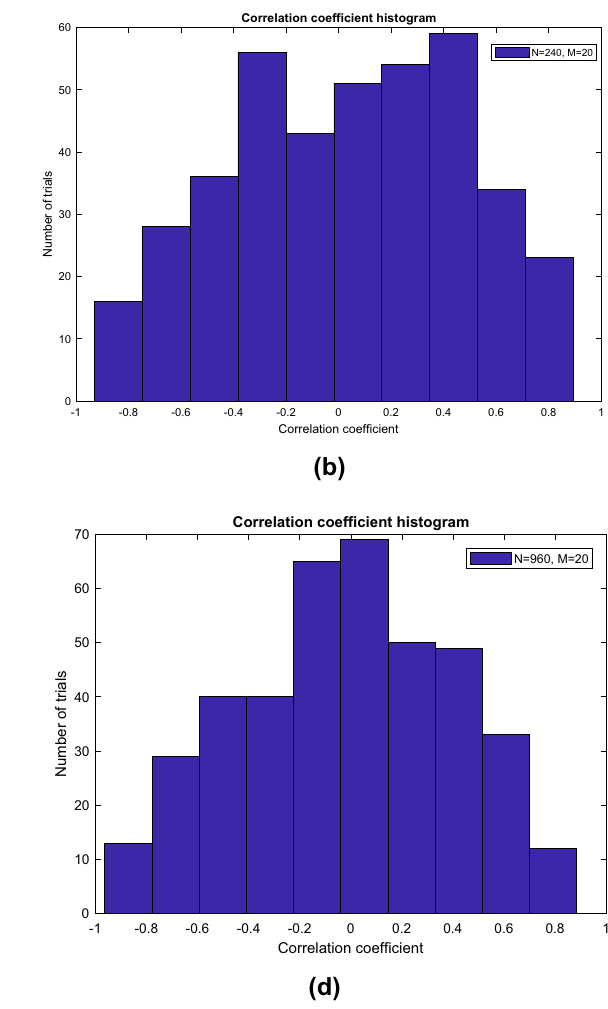
Fig. 9 Distribution of the correlation coefficient between the actual data and the estimated data (AUD/CAD) for a N = 120, M = 20, b N = 240, M = 20, c N = 480, M = 20, d N = 960, M = 20. None of the